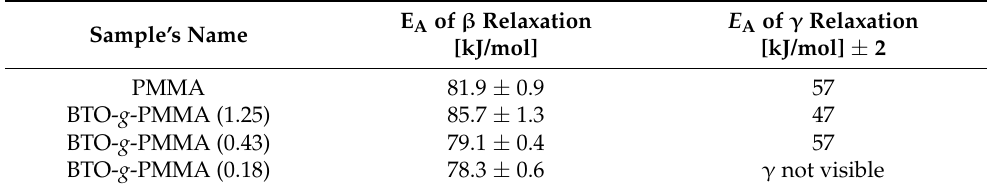
Table 3. Activation energies of local relaxations calculated for neat PMMA and BTO- g -PMMA core–shell